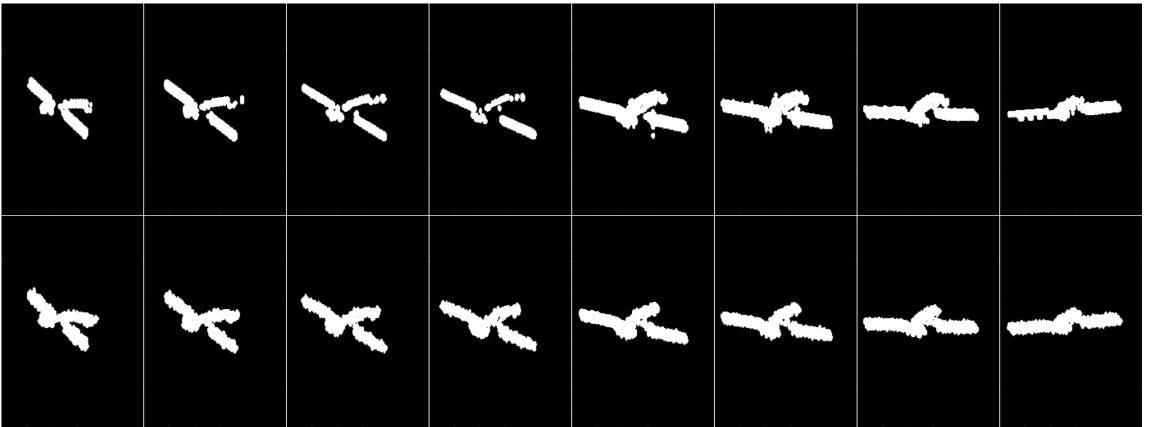
Figure 15. Comparisons between the ISAR image sequence and the projection image sequence of SRST. The first row is part of the observed ISAR image sequence and the second row is the corresponding result of the projection image